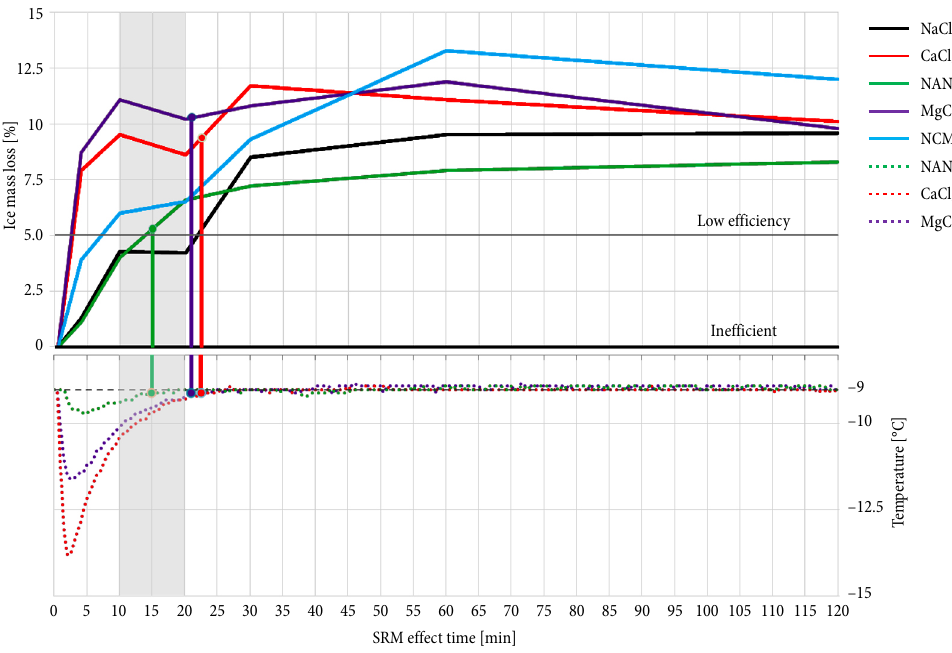
SRM effect time Fig. 2. Loss of ice mass and the change in surface temperature ( t = –9 °C) (Bulevičius et al. 2014)